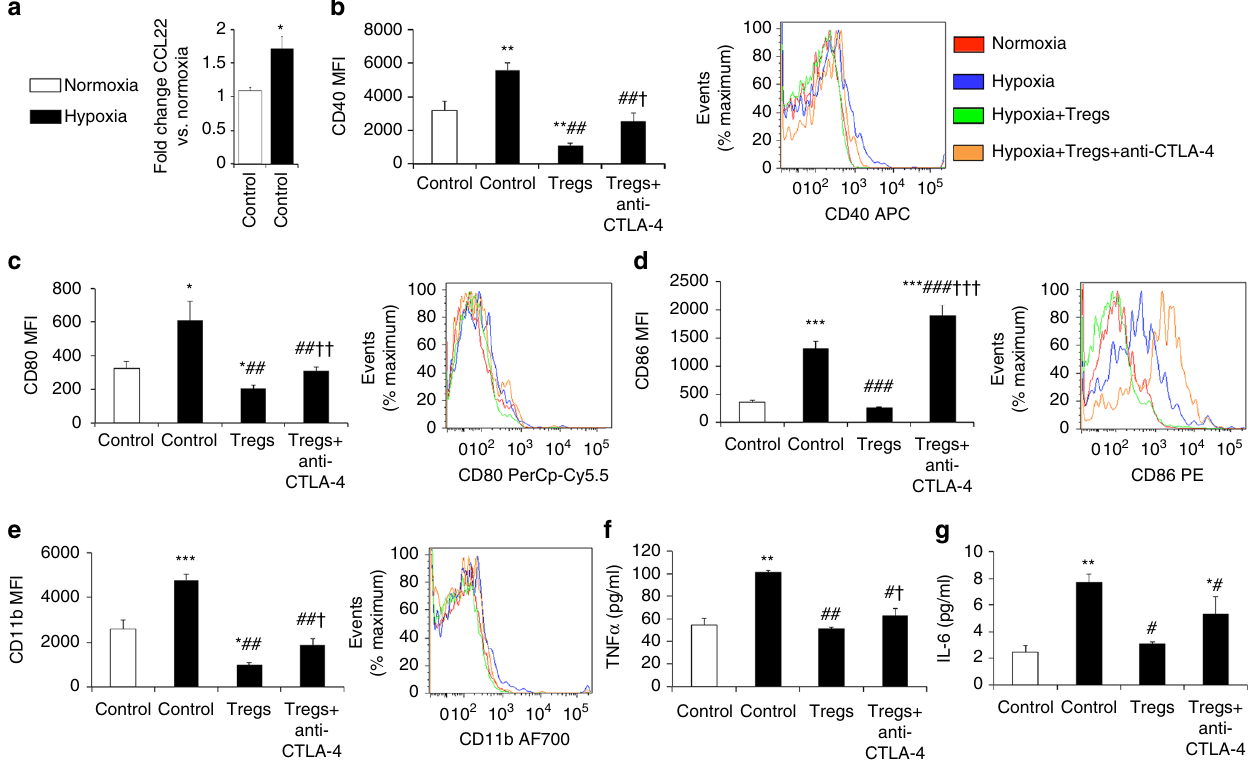
Fig. 7 In vitro Tregs alter the activation of retinal microglia. a Primary cultures of microglia were established from the retinas of 10 to 12-day-old C57BL/6J mice. Quantitative real-time PCR revealed that ccl22 mRNA levels were increased by hypoxia (0.5% O 2 ). * P < 0.05. b – g Retinal microglia were exposed to hypoxia (0.5% O 2 ) and co-cultured with Tregs and a blocking anti-CTLA-4 mAb (10 μ g/ml). Flow cytometry was performed and data are expressed as mean fl uorescence intensity ( MFI ) for b CD40, c CD80, d CD86, and e CD11b. Fluorochromes are allophycocyanin ( APC ), PerCp-Cy5.5, phycoerythrin ( PE ), and AF700. * P < 0.05, ** P < 0.01, and *** P < 0.001 to normoxia control. ## P < 0.01 and ### P < 0.001 to hypoxia control. † P < 0.05, †† P < 0.01, and ††† P < 0.001 to hypoxia + Tregs. In the cell supernatant, an ELISA was used to measure f TNF α and g IL-6 levels in cell supernatant. * P < 0.05 and ** P < 0.01 to normoxia control. # P < 0.05 and ## P < 0.01 to hypoxia control. † P < 0.05 to hypoxia + Tregs. Data are representative of two